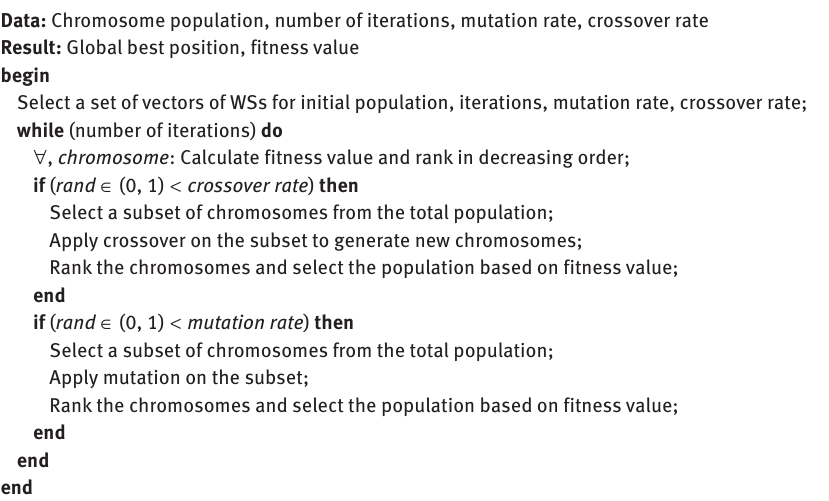
Algorithm 3: GA for WS